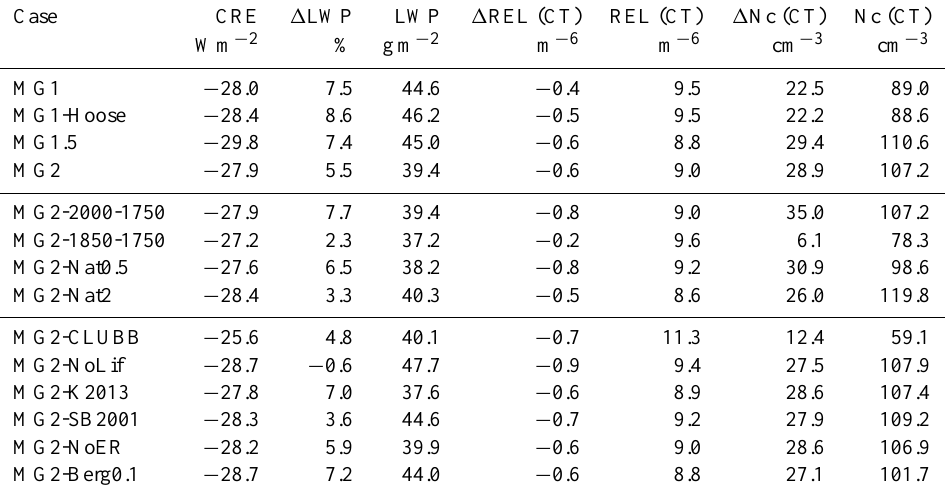
Table 3. Microphysical impact of different sensitivity tests. Mean CRE, change in LWP (%), mean LWP, change in cloud-top (CT) effective radius (REL), mean CT REL, change in CT drop number concentration (Nc) and mean CT N c